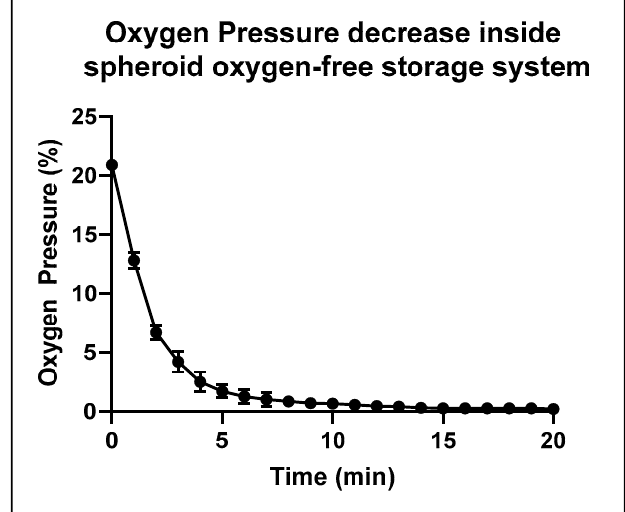
Figure A1. Validation of the oxygen-free atmosphere generating system.